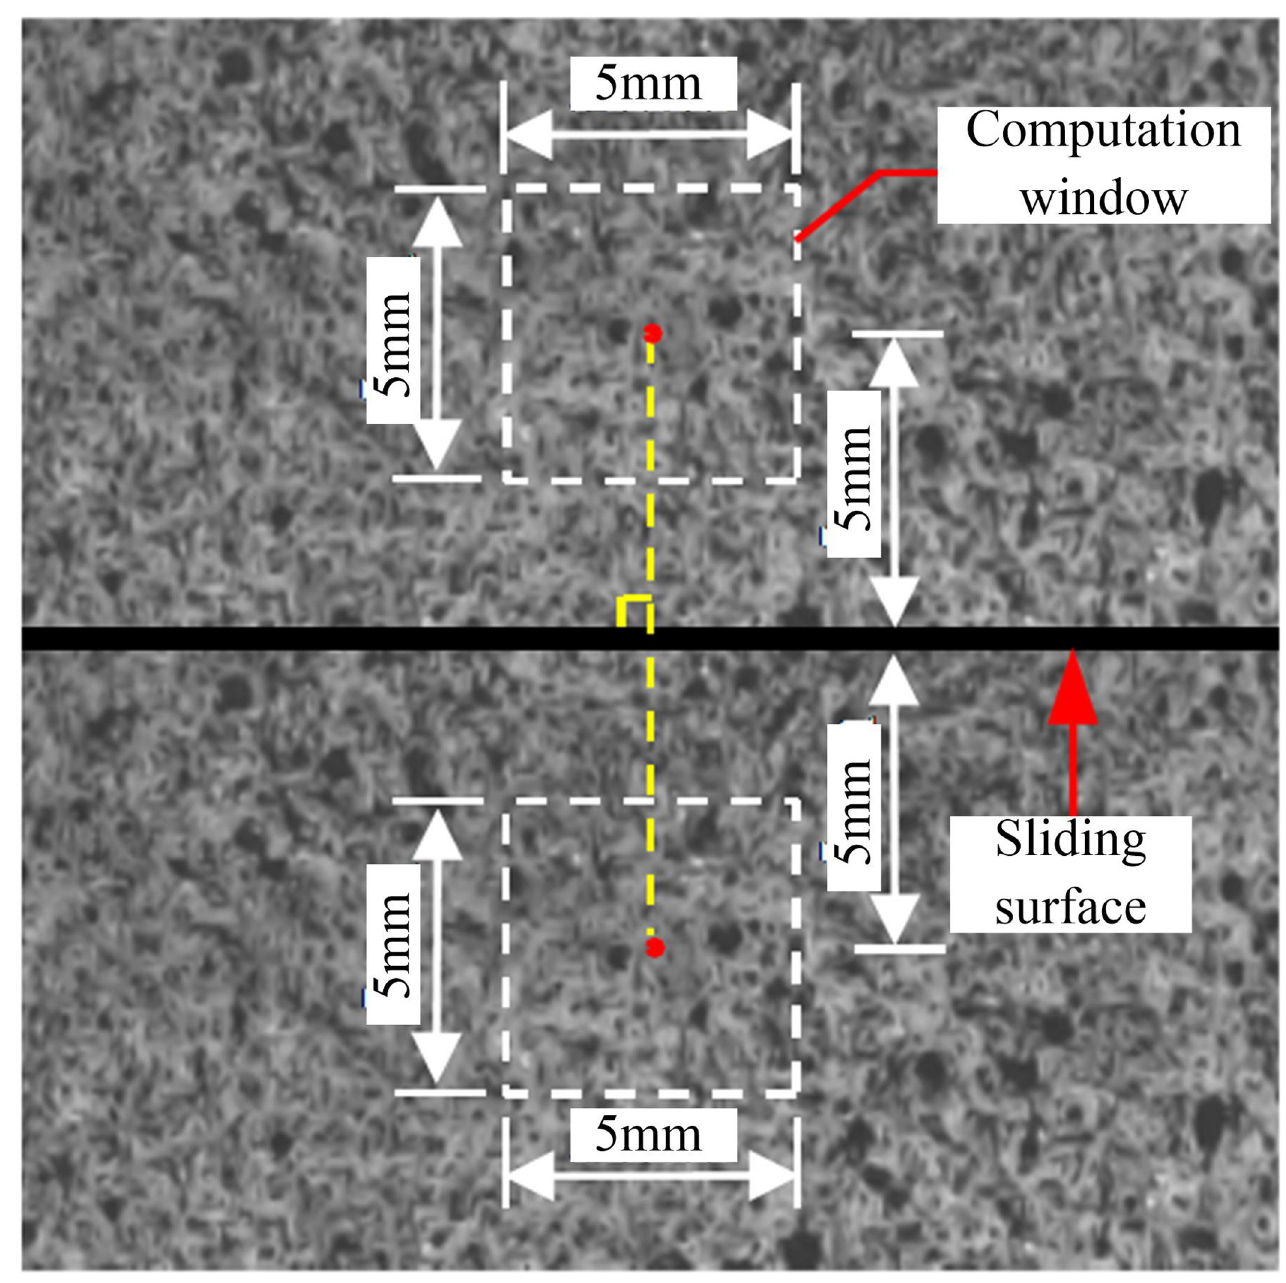
Fig 6. Method for calculating the fault slip